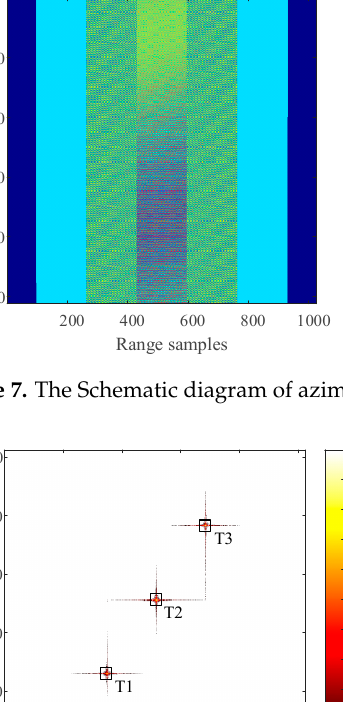
Figure 6. The Distribution of point targets.